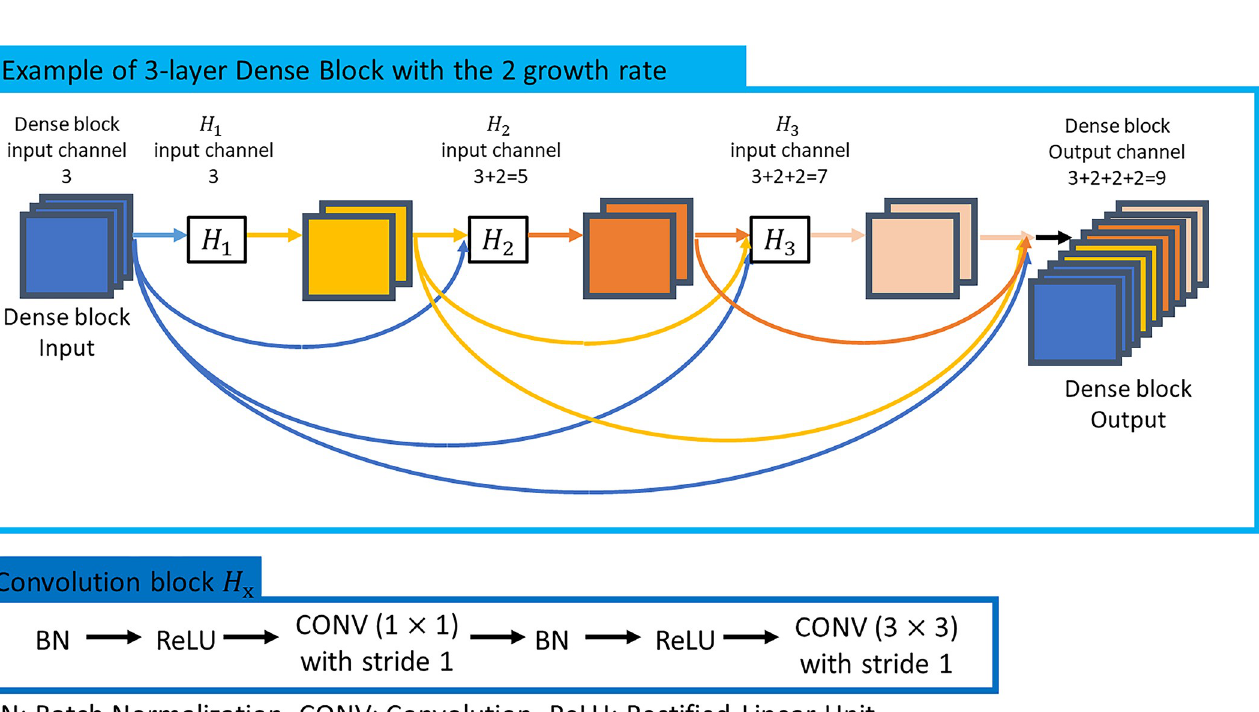
Fig 3. Characteristics of Dense block in DenseNet.